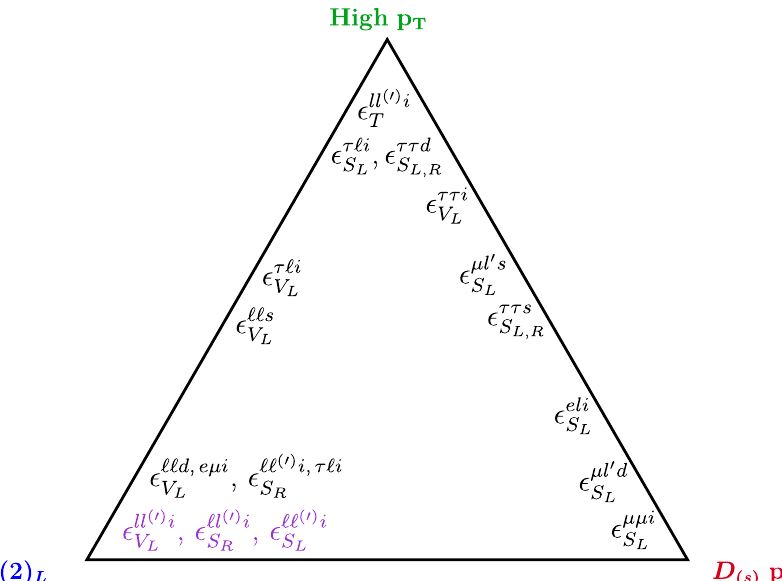
Figure 6 . Interplay between charm physics, high- p T LHC, and SU(2) L relations for the charged- current case ( ‘ = e, µ and l = e, µ, τ ). The proximity of the WCs to a particular vertex of the triangle is determined, approximately, by the relative strength of the corresponding constraints. In purple, those constraints that can be avoided by a particular flavor structure and/or WC